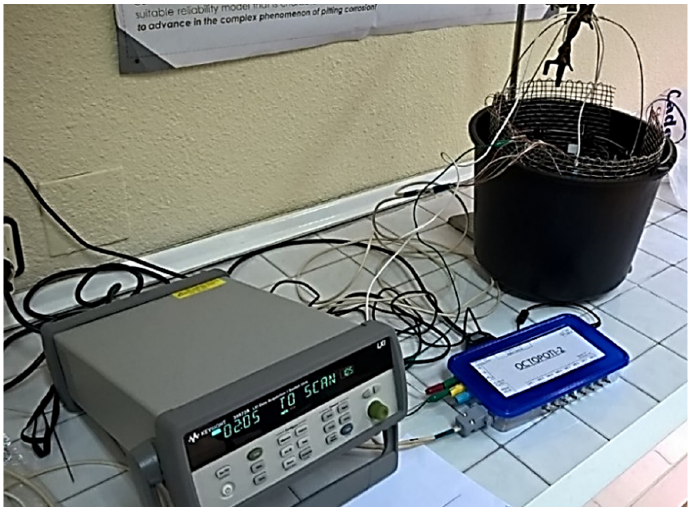
Figure 2. Practical setup for the electrochemical cell for corrosion tests.